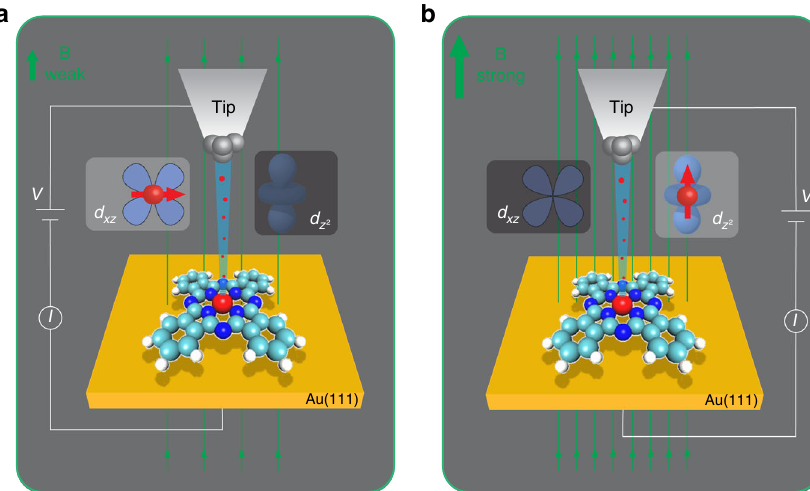
Fig. 1 A tunable single-molecule device in the STM junction. a and b Schematics of the electron transport process through an FePc molecule adsorbed on a Au(111) surface at different magnetic fi elds. The Au substrate and STM tip are the two terminals of the single-molecule device. The magnetic fi eld can be viewed as a gate to control the molecular spin states. The arrays of green lines indicate the magnetic fi eld lines. During the electron transport through the FePc, the tunneling electron has two possible passages corresponding to two molecular orbitals ( d z 2 or d xz / d yz ). At weak magnetic fi eld as in a , the spin direction of Fe is in plane and currents fl ow by the d xz / d yz orbital. At strong magnetic fi eld as in b , Fe spin is aligned to the magnetic fi eld and electrons tunnel preferentially through the d z 2